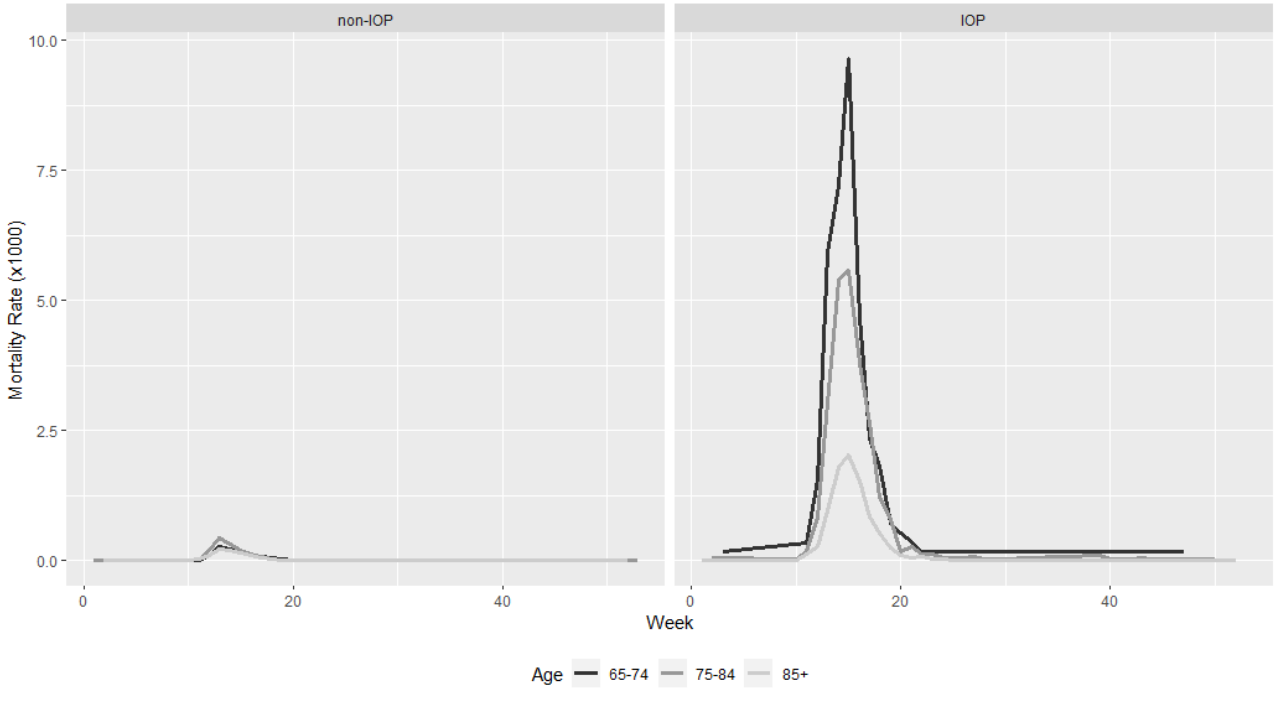
Figure 3. Age-adjusted mortality curves of COVID-19 cases by place of residence. The analysis of comorbidities and their impact on the probability of death from COVID-19 during the first wave of the pandemic shows that obesity is associated with an increased probability of death (sHR 1.08, 95% CI 1.03–1.15) and that this increased probability is only found among non-IOPs (HR 1.10, 95% CI 1.03–1.19). In the case of dementia, we also observed an increased likelihood of death overall, in the whole cohort (HR 1.21, 95% CI 1.12–1.28), but in this case it is associated with an isolated increased likelihood among IOPs (HR 1.32, 95% CI 1.22–1.44). The Cox model applied on the entire cohort was stratified by IOP, given that the ANOVA analysis between the stratified and non-stratified model showed clearly significant differences ( χ 2 = 11,476; p ≤ 0.001). Thus, the concordance of the stratified model used was 0.82 (SE = 0.002). The model used among the IOP population obtained a concordance of 0.76 (SE = 0.004), while in non-IOP it was 0.85 (SE = 0.003). (Table 5). Table 5. Results of multivariate risk models of mortality stratified by place of residence. Entire Cohort